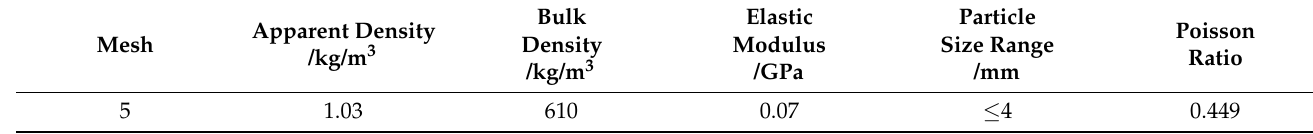
Table 2. Basic performance indicators of rubber particles.